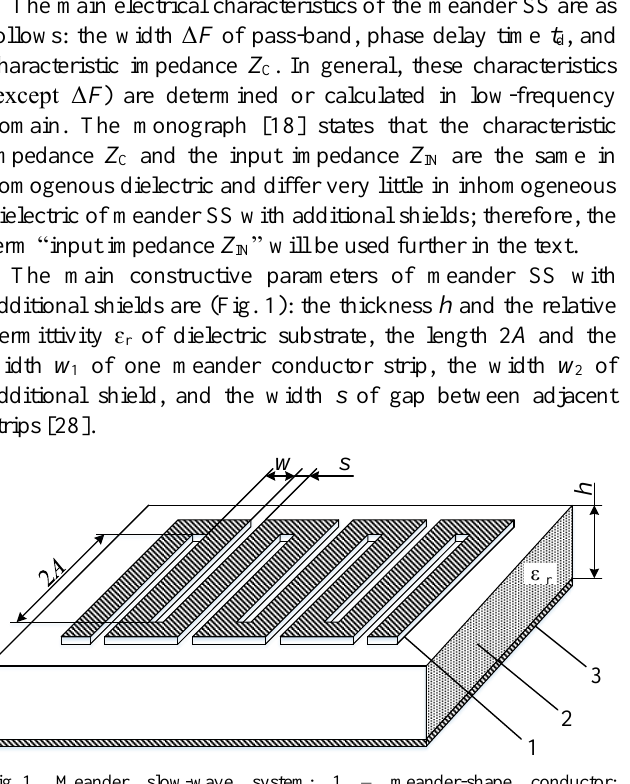
Fig. 1. Meander slow-wave system: 1 – meander-shape conductor; 2 – dielectric substrate of relative permittivity ɛ r ; 3 – external shield